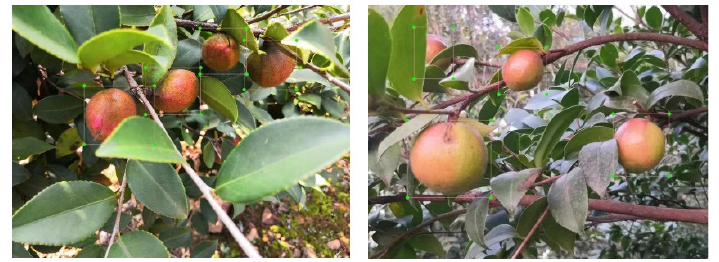
Figure 2. Examples of labeled Camellia oleifera fruit